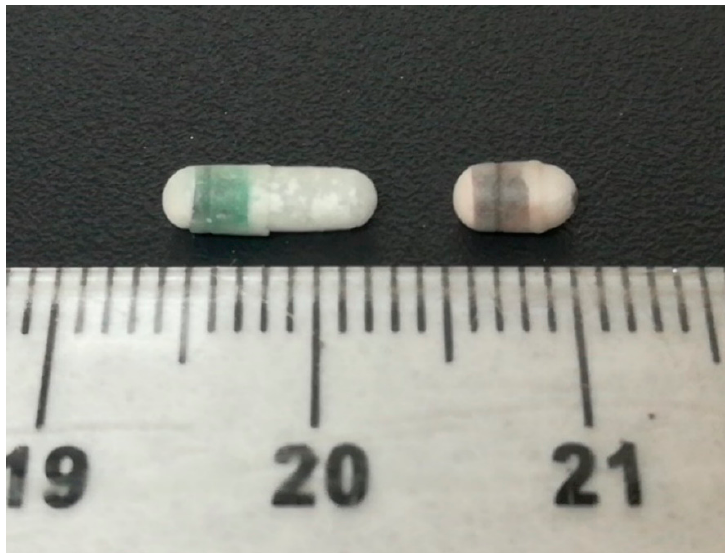
Figure 1. Picture of the coated capsules, size 9 (left) and size 9h (right).